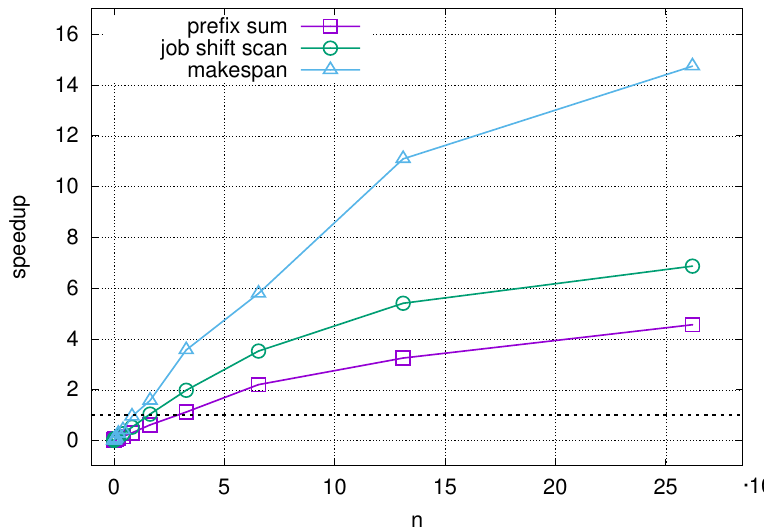
Figure 4. Measured GPU vs. CPU speedups as a function of the number of jobs for the prefix sum, job shift scan and makespan. Black dashed line indicates a speedup of